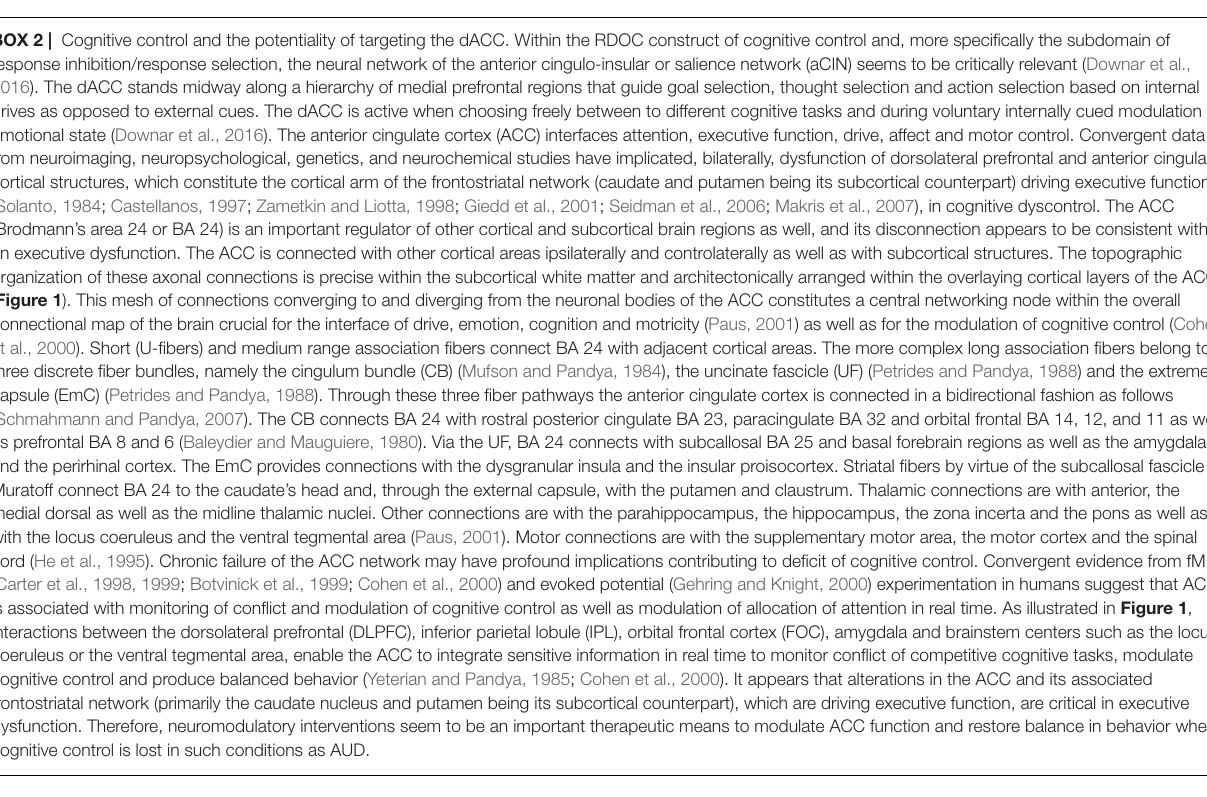
FIGURE 1 | Schematic diagram of dACC circuitry implicated in modulation of cognitive control. BA, Brodmann’s area; DLPFC, dosolateral prefrontal cortex; IPL, inferior parietal lobule; LC, locus coeruleus; SMA, supplementary motor area; VTA, ventral tegmental area.